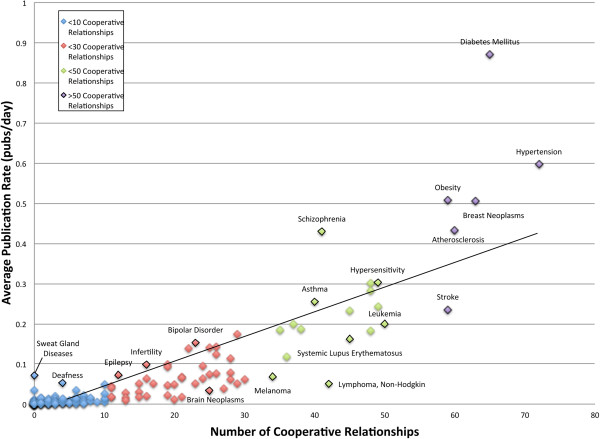
Average rate of publication (publications/day) of disease-specific research fields with various numbers of cooperative partnerships. From this figure it is clear that diseases publish more frequently when cooperating with a larger variety of genetically related diseases (r2=0.8585).